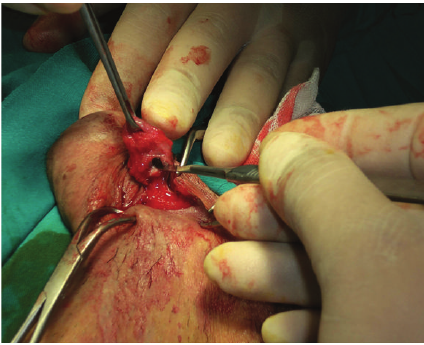
Figure 2: Case 1: surgical dissection of the urethral diverticulum.